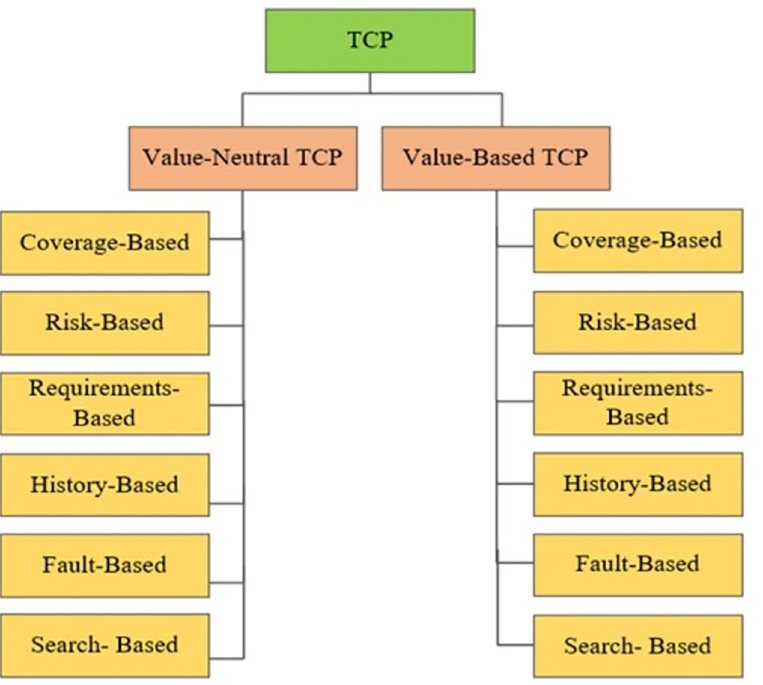
Fig 8. Enhanced taxonomy of test case